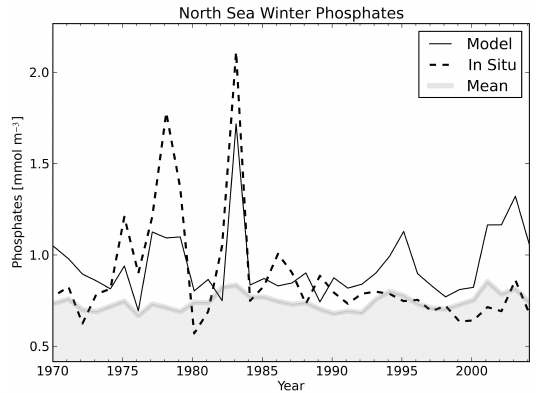
Fig. 15. North Sea mean winter phosphates time series: the black line is the matched model mean winter phosphates, the dashed line the mean winter in situ phosphates, and the grey area shows the MLD-averaged mean phosphates of the North